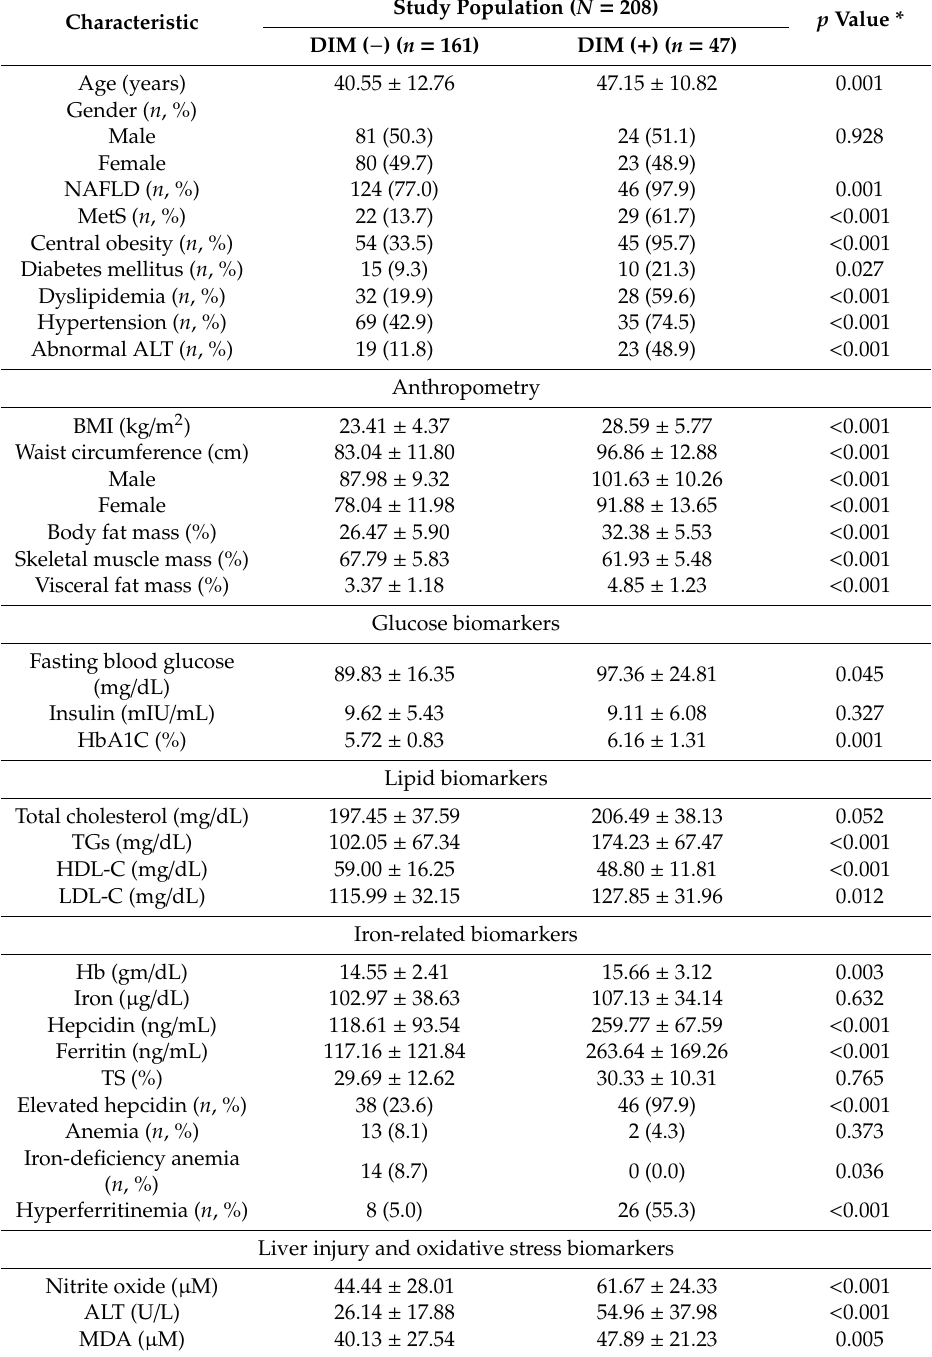
Table 1. Baseline characteristics of the study population according to the dysregulated iron metabolism (DIM) status ( N =